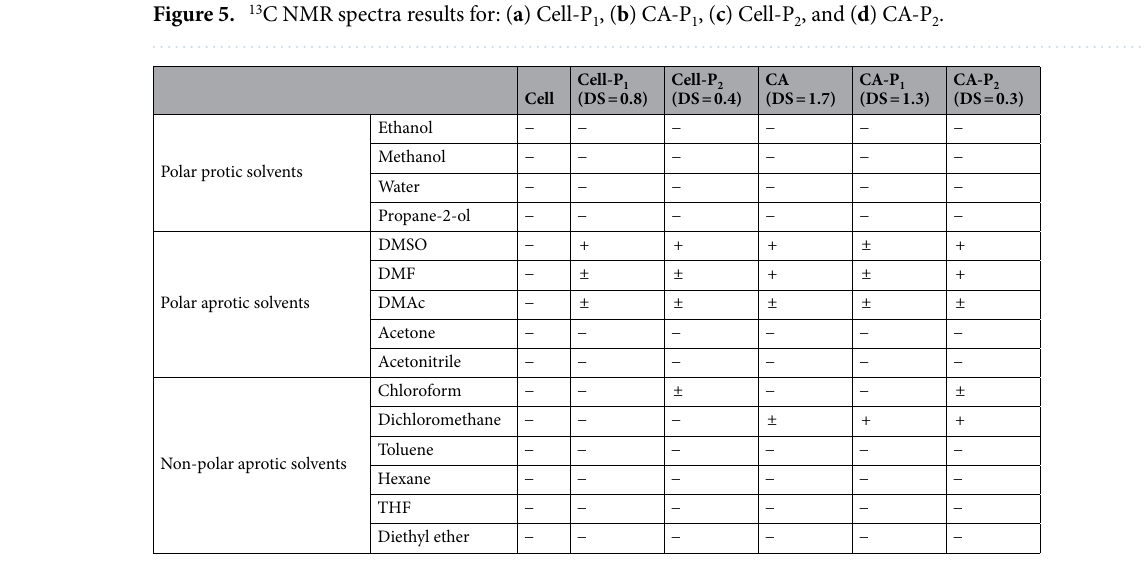
Table 2. Solubility tests for cellulose carbamate (Cell-P 1 and Cell-P 2 ), and cellulose acetate carbamate (CA-P 1 , CA-P 2 ). + : Soluble, ± : Partly soluble, −: